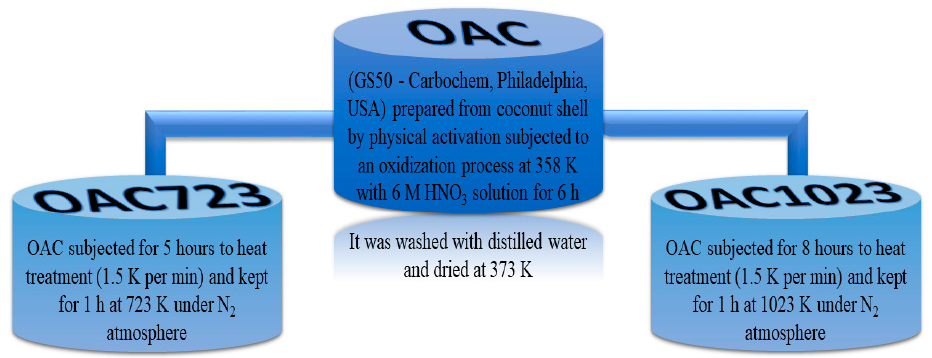
Figure 8. Scheme of the conditions and modifications of the samples [48].